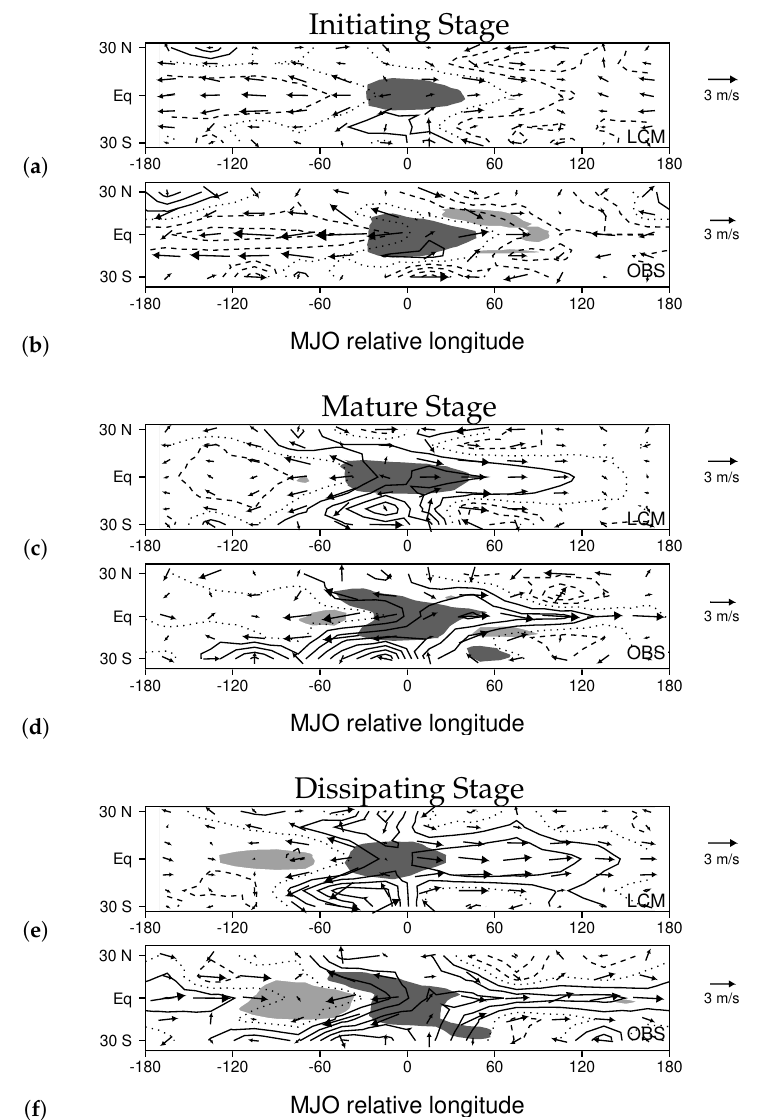
Figure 8. Horizontal structure of simulated and observed composite MJOs. ( a , b ) Initiating stage structure for LCM and observations respectively. ( c , d ) Mature stage structure for LCM and observations respectively. ( e , f ) Initiating stage structure for LCM and observations respectively. In each panel average tropospheric temperature is contoured with 0.1 K contour interval (zero dotted, negative dashed), and vectors illustrate 200 hPa flow. The observed MJO structure is adapted from